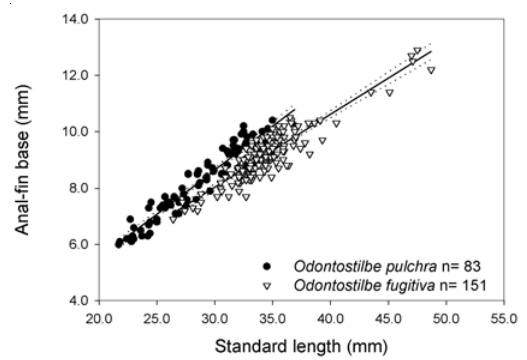
Fig. 4. Upper jaw length as a function of head length for males, females and unsexed specimens of Odontostilbe pulchra , against O. fugitiva .